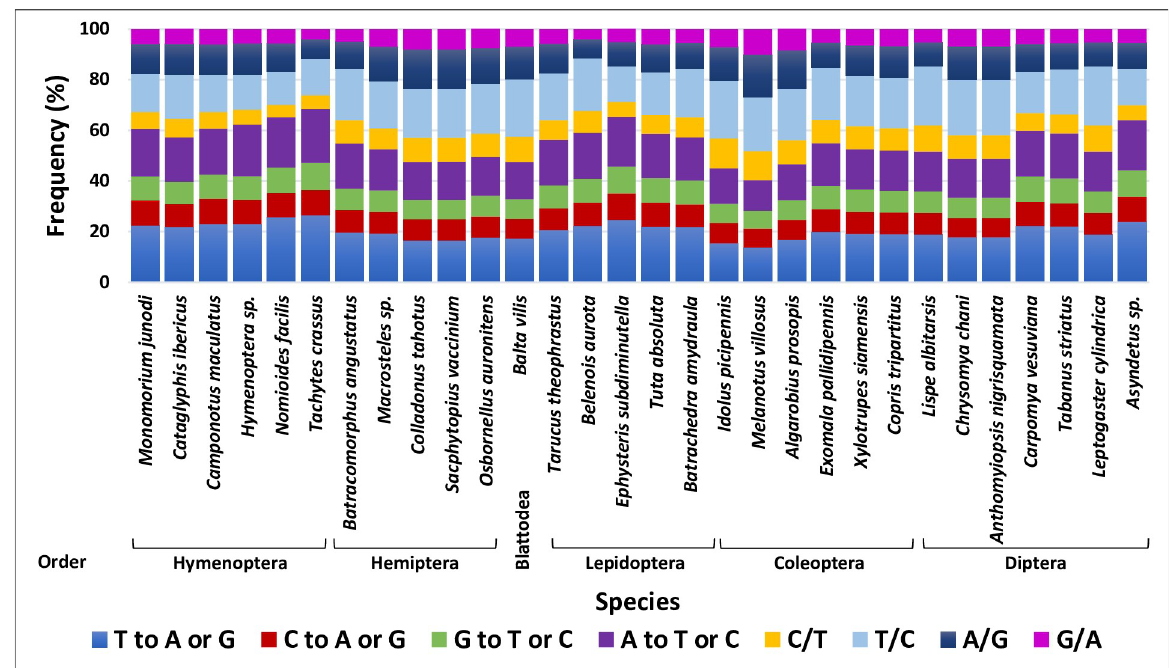
Fig 6. Nucleotide substitution matrix derived based on the COI barcode. Maximum composite likelihood estimates of the pattern of nucleotide substitution to detect transition and transversion frequencies based on DNA sequence alignment in COI barcode of species in the six insect